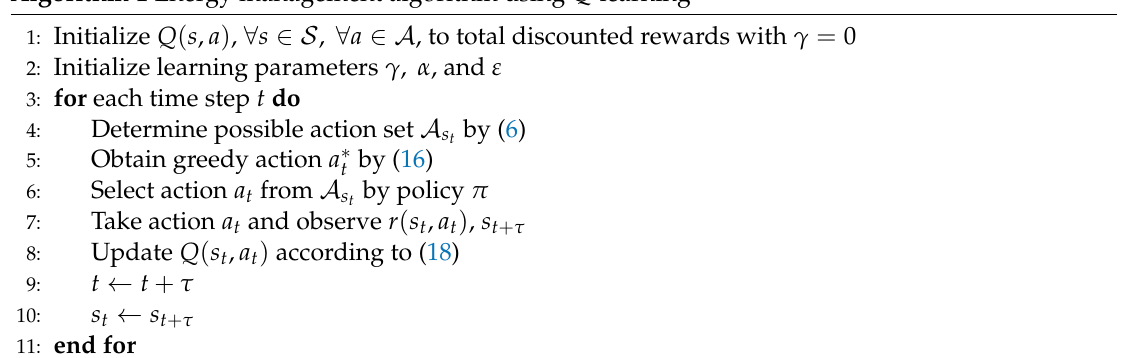
Algorithm 1 Energy management algorithm using